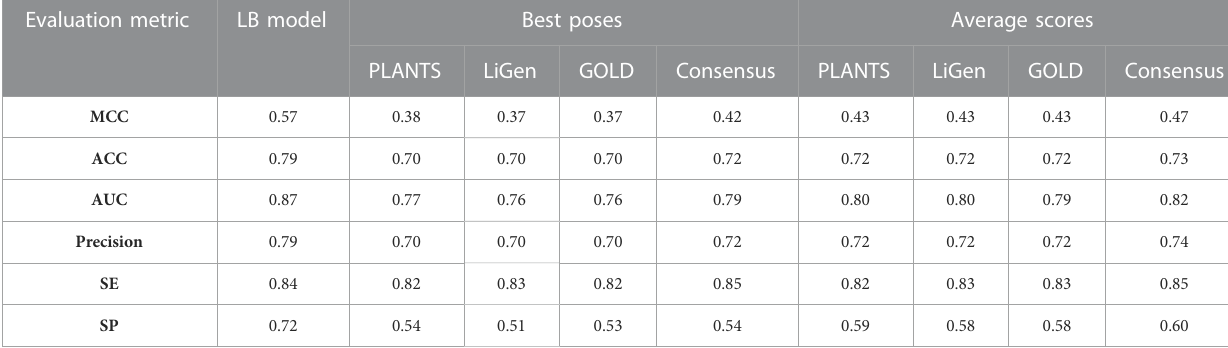
TABLE 2 MCC, Accuracy (ACC), AUC, Precision, Sensitivity (SE) and Speci fi city (SP) values of the generated classi fi cation models. Evaluation